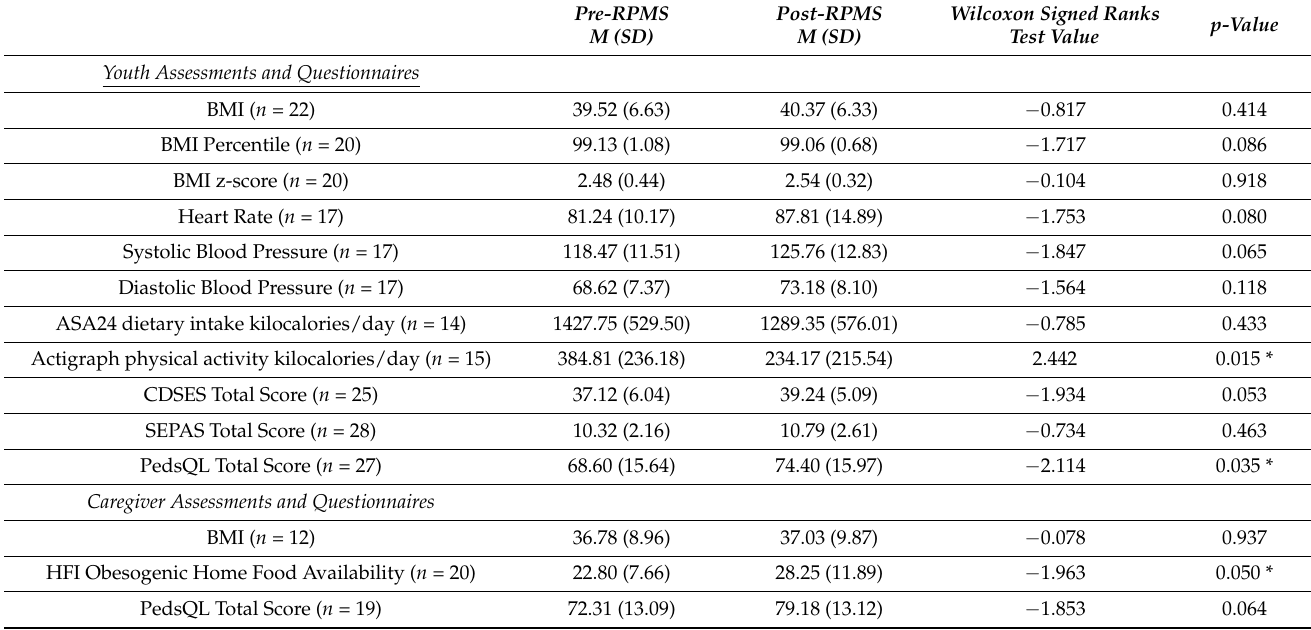
Table 3. Pre-Treatment and Post-Treatment RPMS Comparisons and Statistical